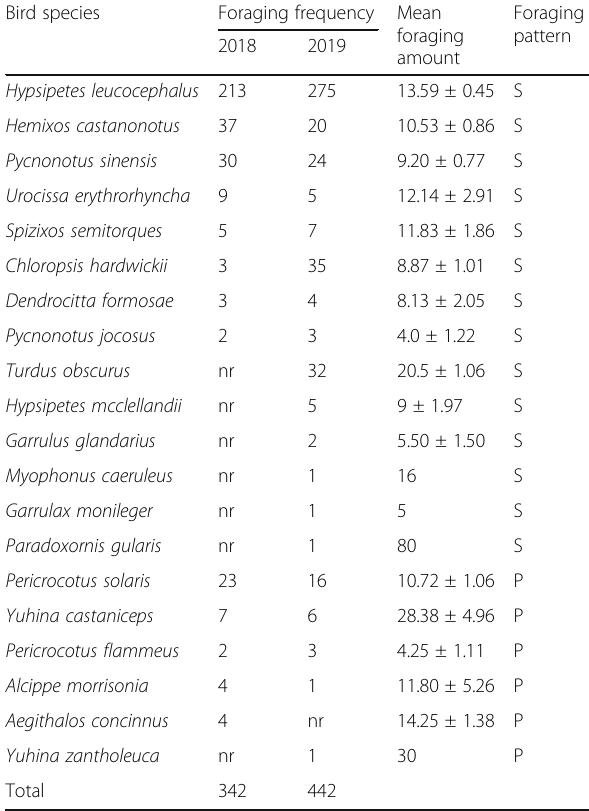
Table 1 Frugivorous birds forage on the fruits of Taxus chinensis in the patchy habitat of yew ecological garden, Fujian Province,